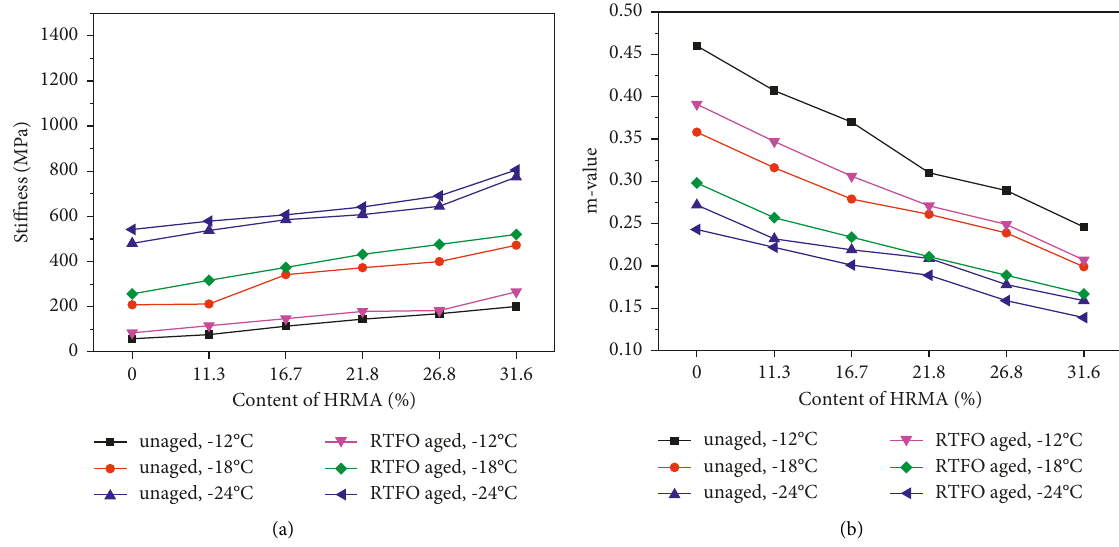
Figure 12: Low-temperature rheological properties of different asphalt binders versus HRMA content: (a) stiffness and (b) m -value.